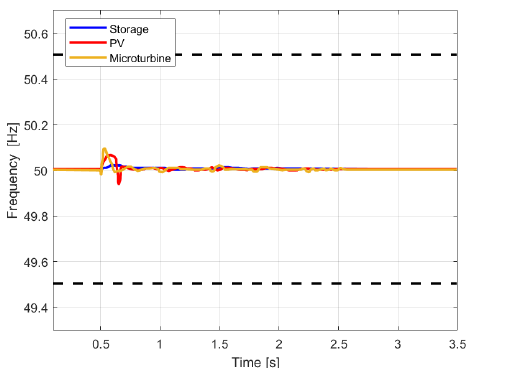
Figure 15. Simulation D: Frequencies. The dashed black lines represent the frequency limits f min and f max